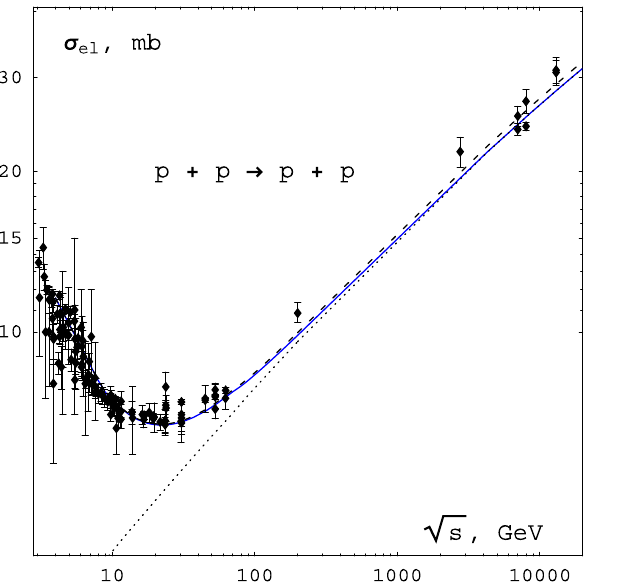
exchangecontributionistakenintoaccount.Thedottedlinescorrespond to the one-Reggeon eikonal model, wherein just the SP exchanges are taken into account